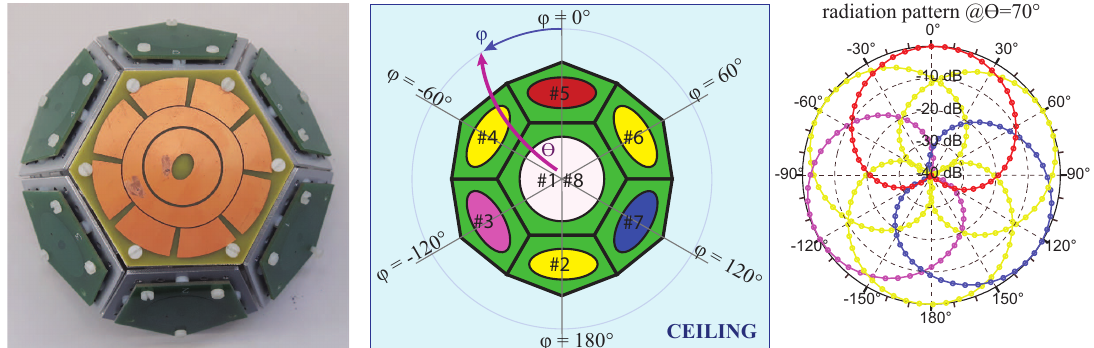
Figure 3. Switched-beam array anchor node